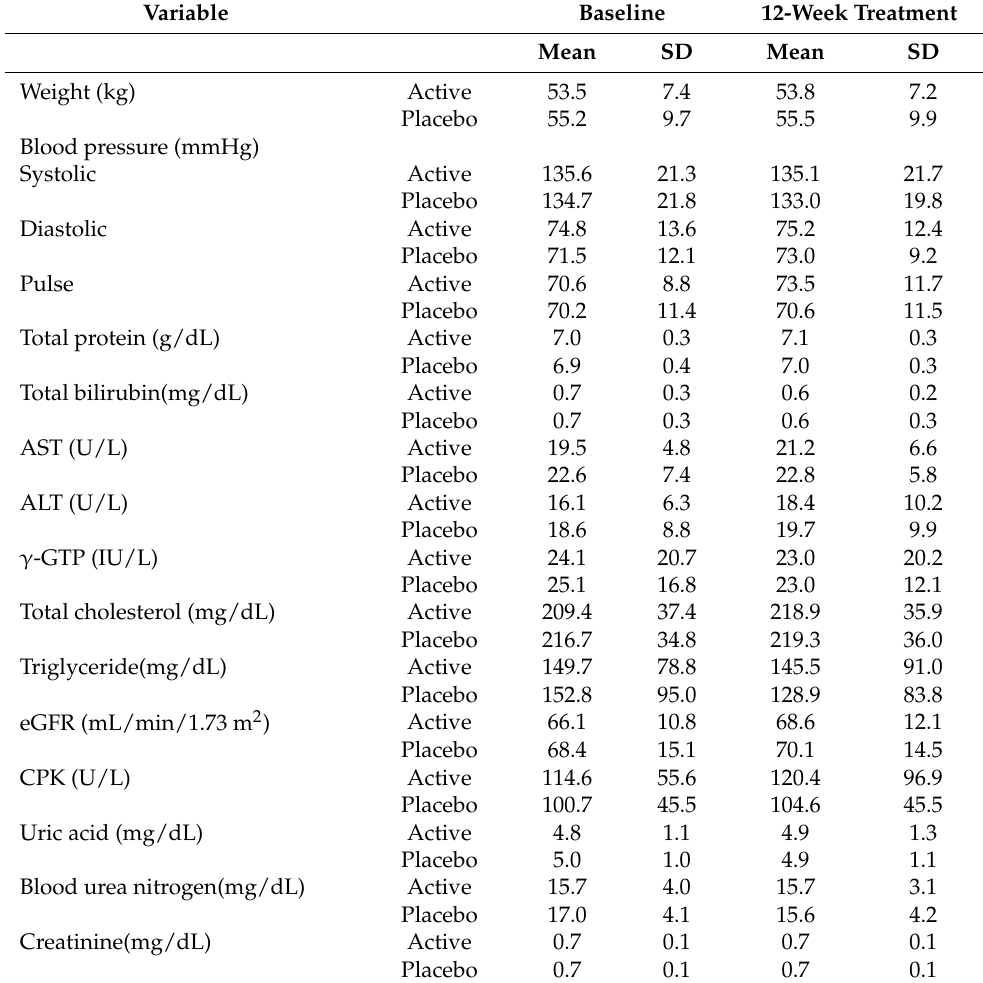
Table 5. Mean difference for demographics or blood and urine test results from the baseline and 12-week treatment with SPE (active) and